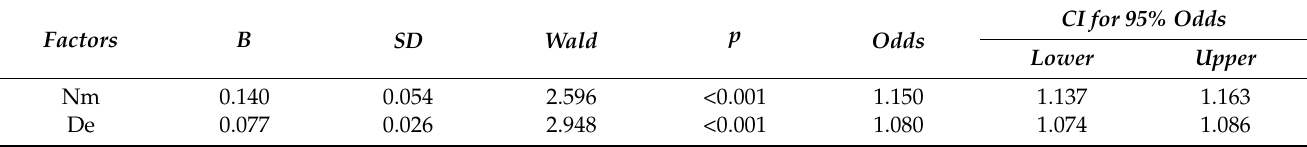
Table 4. Logit model for Emotional Exhaustion (EE) ˆL s ( Nm,De ) = ˆB 0 + ˆB Nm Nm + ˆB De De; s = 1,2.